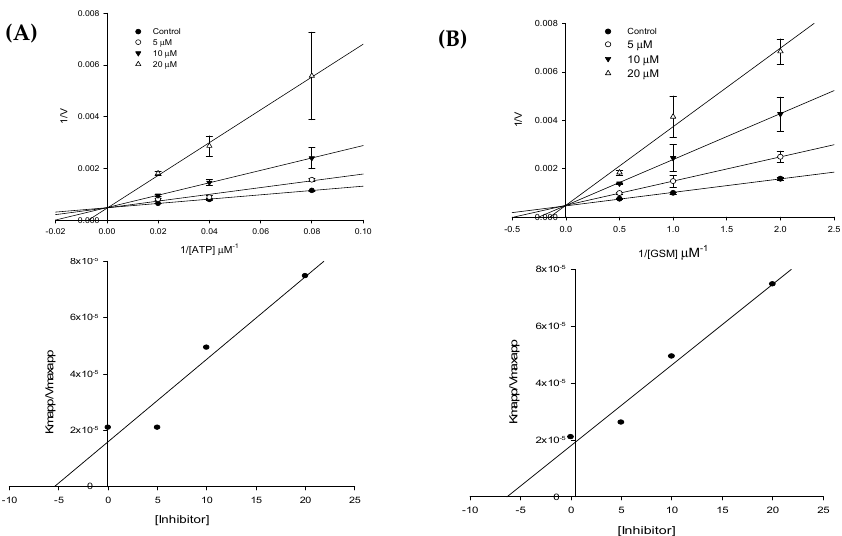
Figure 3. Lineweaver–Burk plots for GSK-3 β inhibition by Sal B in the presence of various concentrations of ( A ) ATP and ( B ) GSM. Graphs below each Lineweaver-Burk plots represents secondary plots.